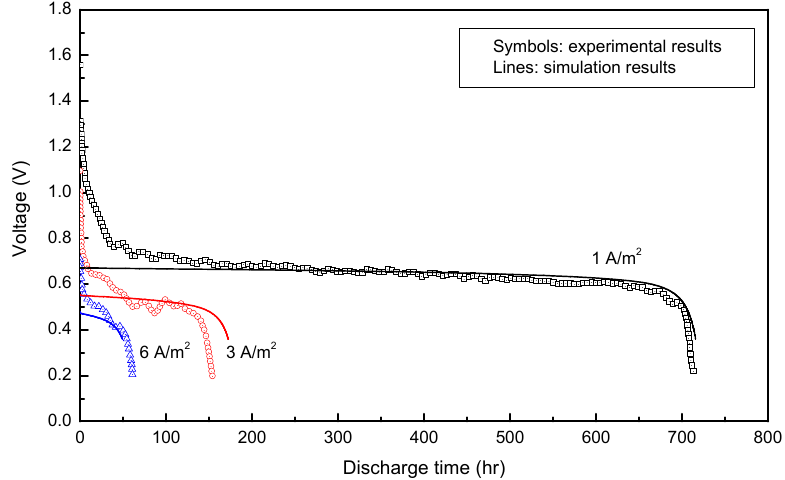
Figure 6. Discharge curves for the Al–air battery for model and experimental data [10].